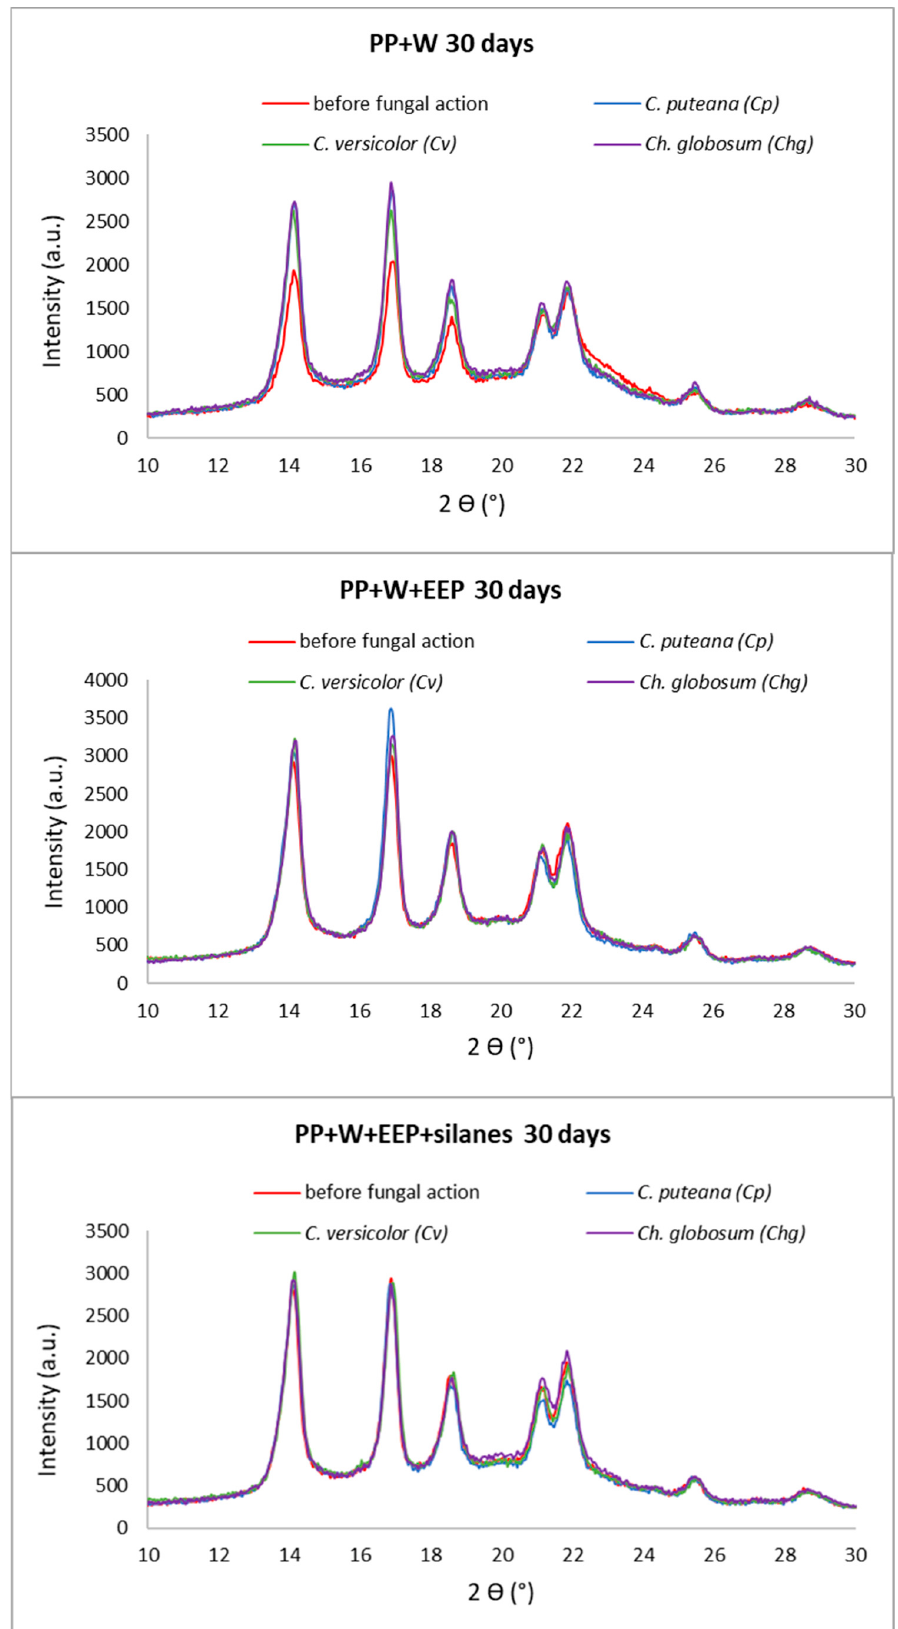
Figure 8. X-ray diffraction pattern of composites after 30 days of UV aging.